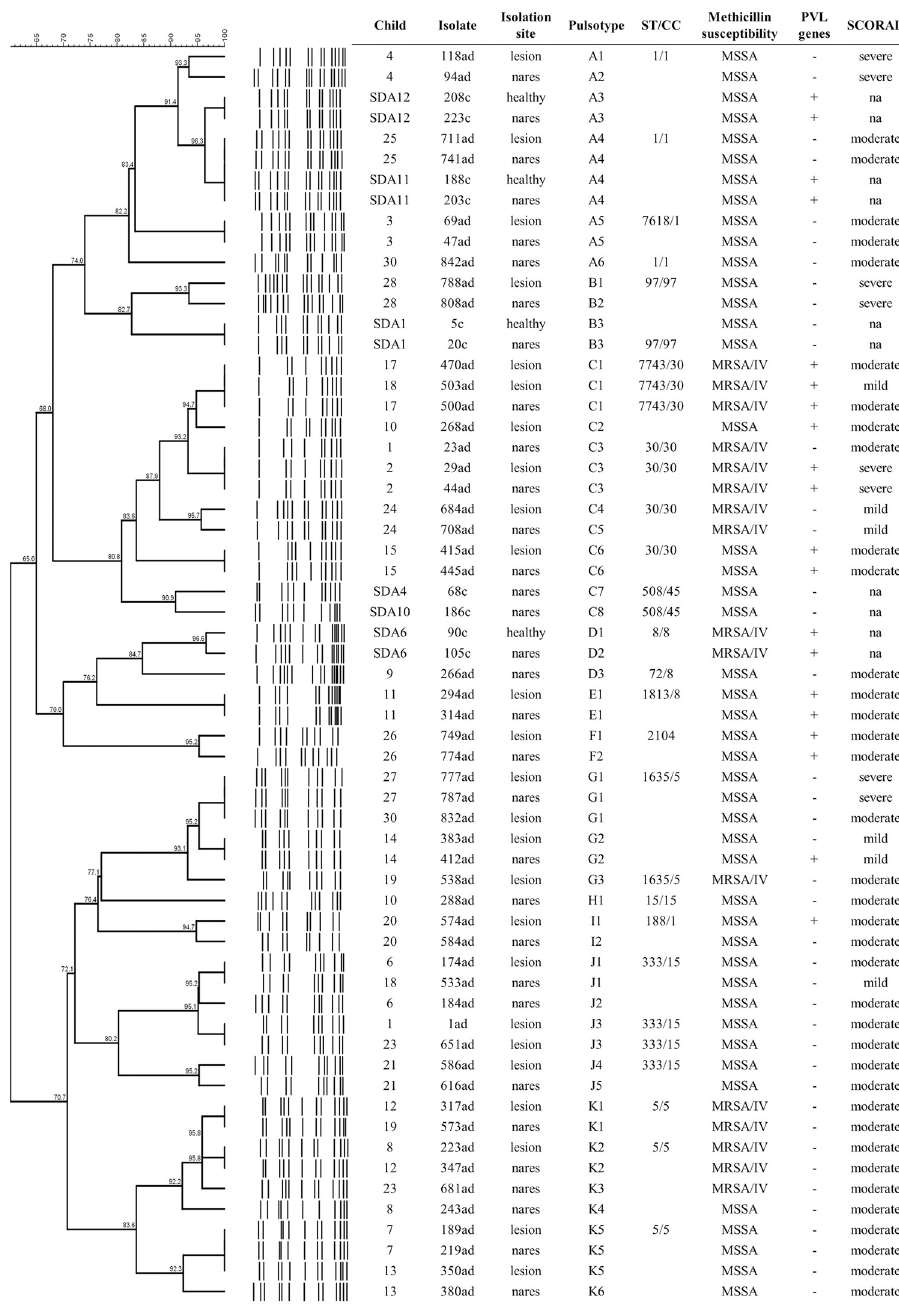
Fig 3. Dendrogram of the clonal profiles obtained after digestion with the restriction enzyme Sma I, and general characteristics of 61 S . aureus isolates from nasal and skin colonization of children with and without AD. CC- Clonal complex; MRSA/IV- Methicillin-resistant Staphylococcus aureus presenting SCC mec IV; MSSA- Methicillin- sensitive Staphylococcus aureus ; na- Not applicable; PVL- Panton-Valentine leukocidin; SDA- Child without atopic dermatitis; ST-